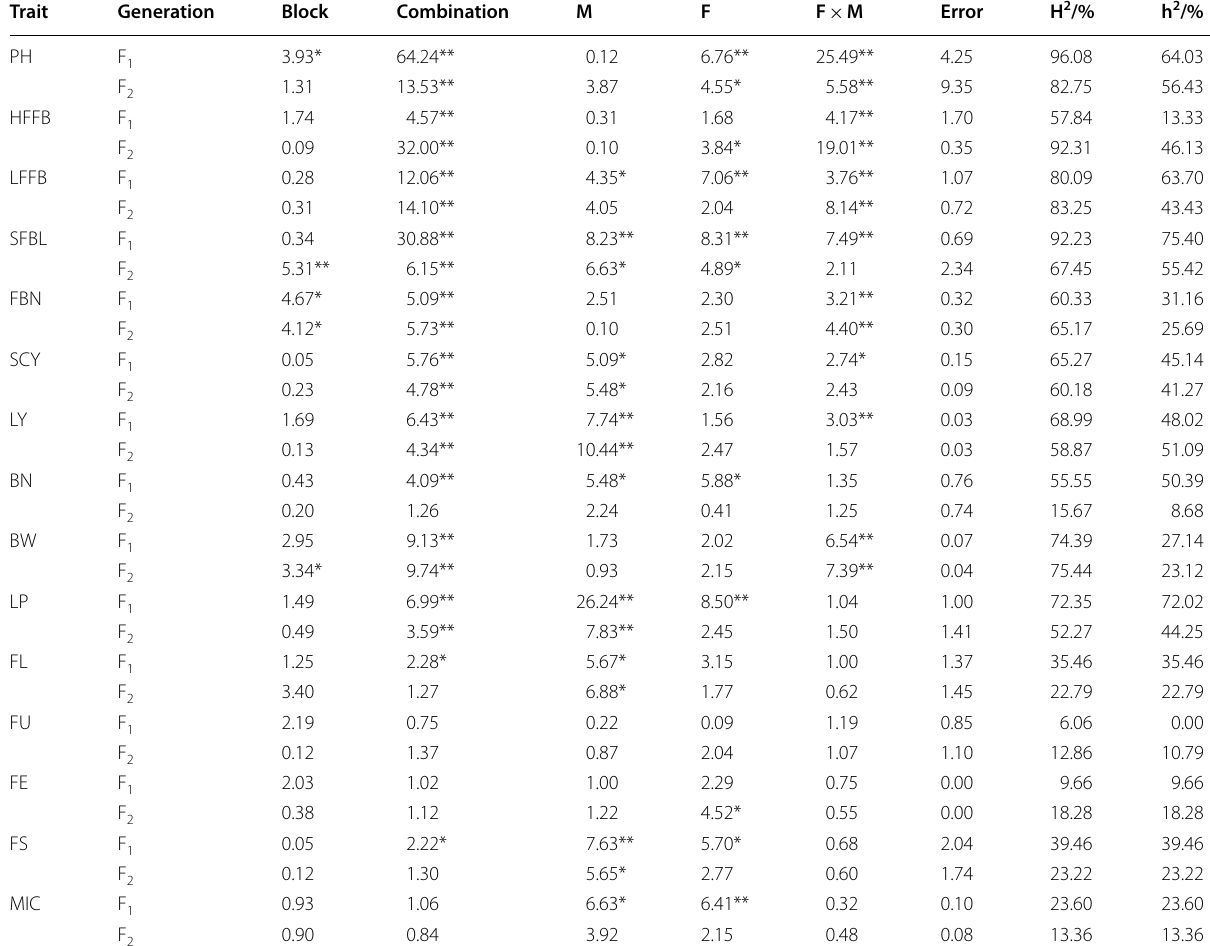
F female, M male * and ** denote significant differences at 0.05 and 0.01 levels, respectively